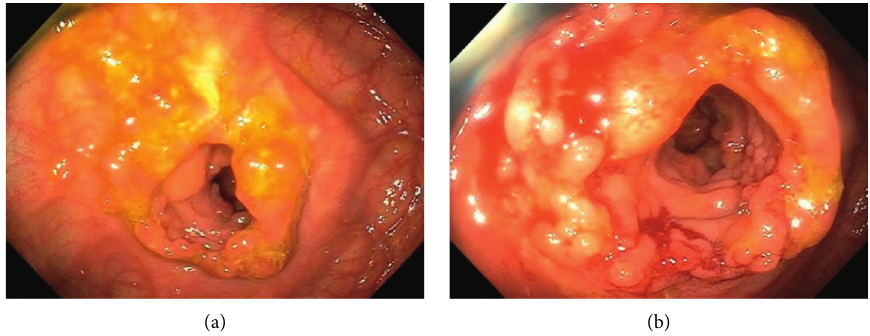
Figure 3: Posttreatment colonoscopy reveals interval improvement of colonic stenosis resolution of the inflammatory mass.